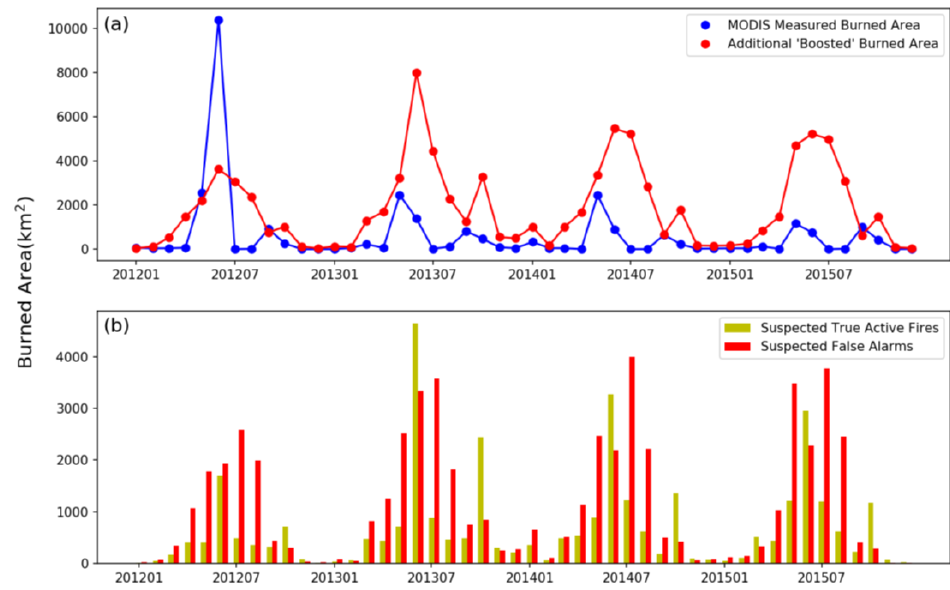
Figure 5. Monthly fire activity for 2012–2015 for eastern China (area shown in Figure 1). ( a ) GFED4-reported burned area (BA) (derived only from the MODIS MCD64A1 BA product), along with the additional BA reported in GFED4.1s that comes from the ‘small fire boost’ derived using the method reported in [11]). Most of the GFED4.1s BA comes from the SFB rather than actual MODIS BA mapping. ( b ) ‘Boosted’ BA data classified as either BA derived from suspected true active fire detections, or BA derived from suspected AF false alarms (classifiedusing landcover-based masking; see Figure 4).